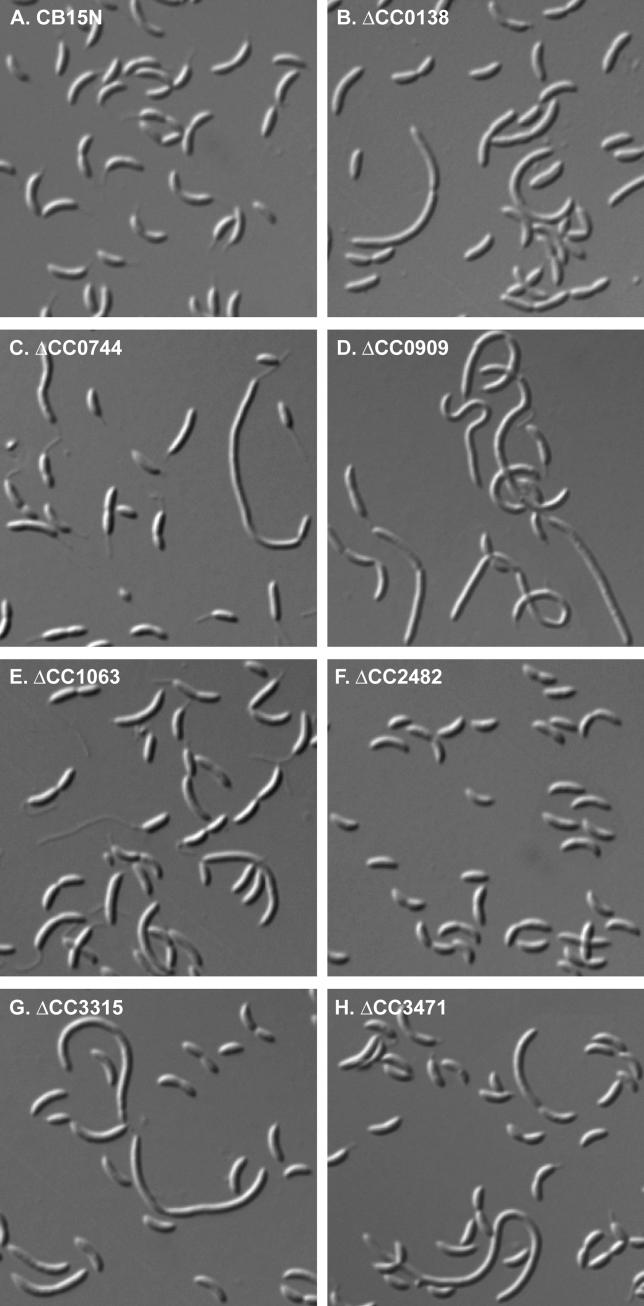
Morphology of Selected Deletion StrainsDeletion strains were harvested at mid-log phase and imaged using differential interference contrast microscopy. Strains: (A) wild-type CB15N, (B) ΔCC0138, (C) ΔCC0744, (D) ΔCC0909, (E) ΔCC1063, (F) ΔCC2482, (G) ΔCC3315, and (H) ΔCC3471.